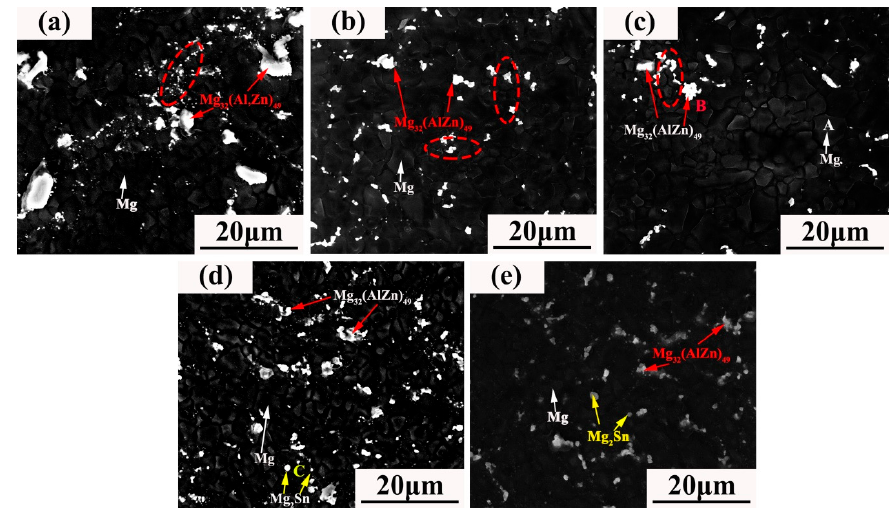
Figure 3. SEM images of extruded Mg–5Zn–4Al–xSn alloys: ( a ) ZAT540, ( b ) ZAT540.5, ( c ) ZAT541, ( d ) ZAT542, and ( e ) ZAT543.